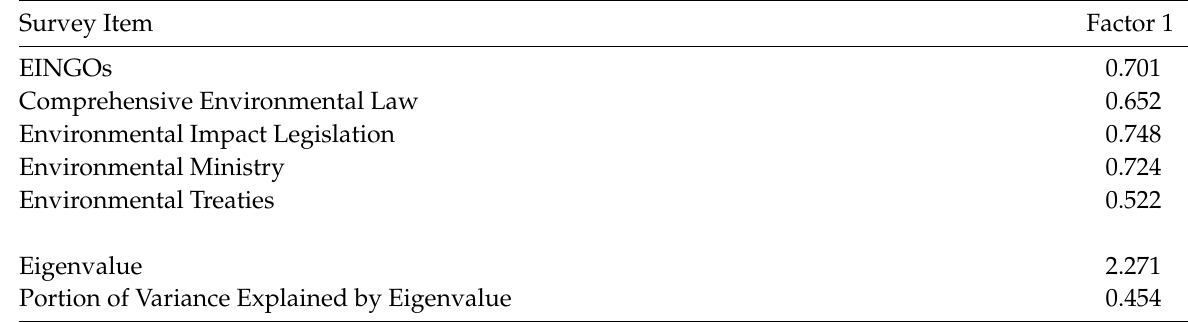
Table 3: Principal component factor analysis of engagement with world environmental norms. Survey